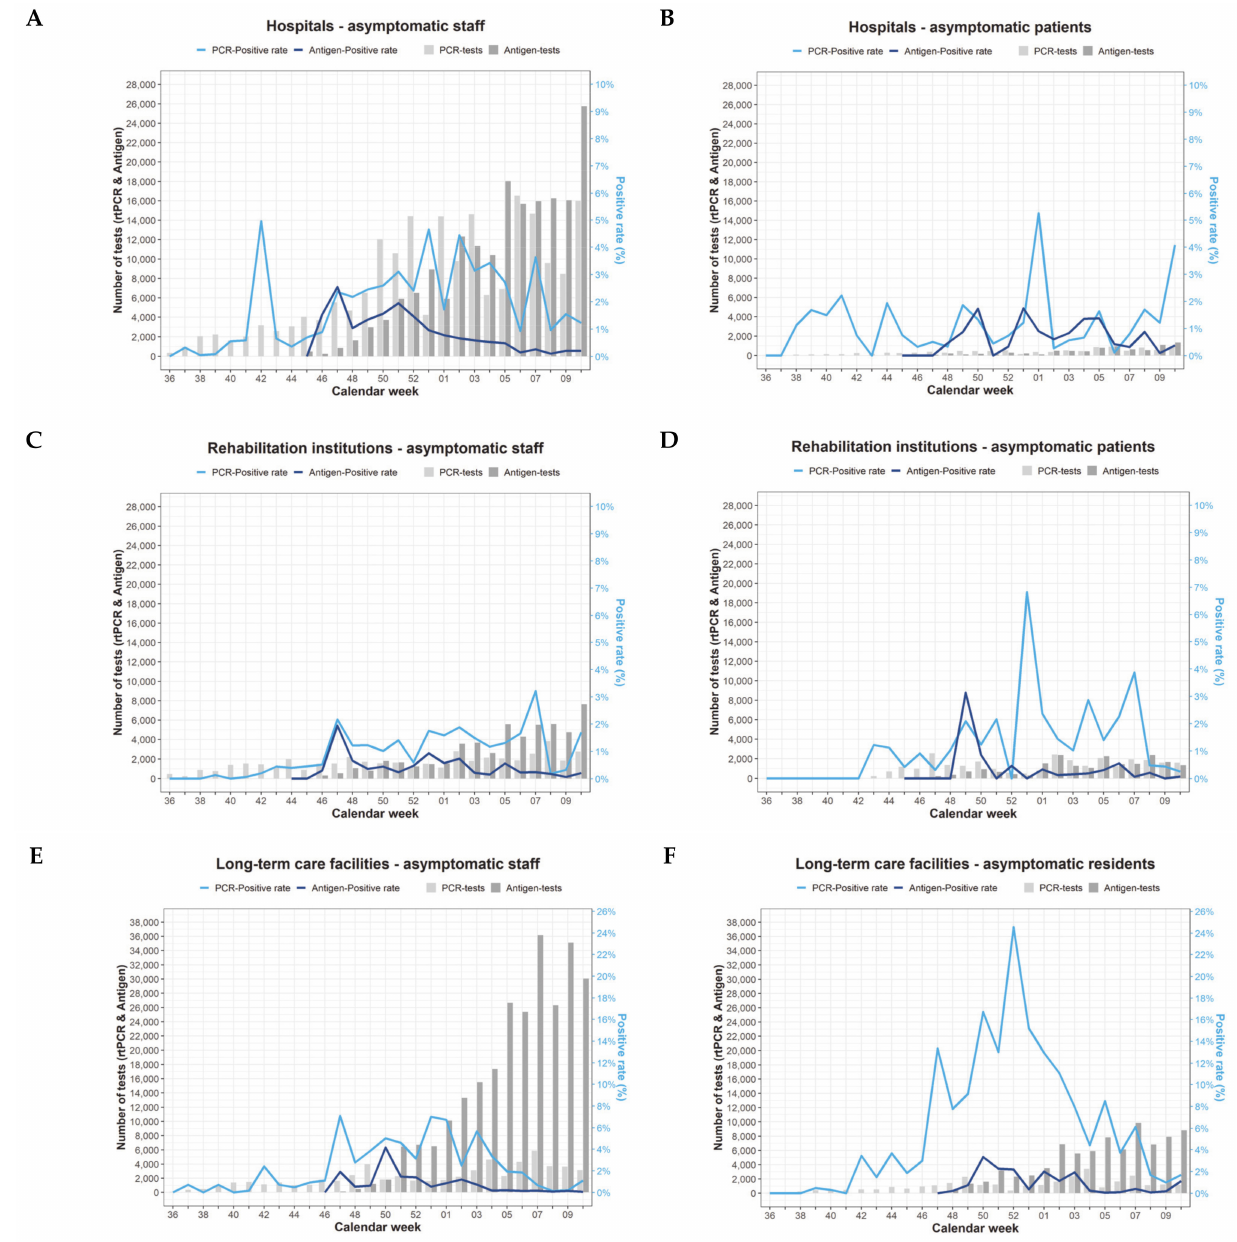
Figure 3. ( A – F ) Temporal patterns of the weekly number of real-time polymerase chain reaction (RT-PCR; light grey bars) and antigen tests (dark grey bars) and the proportion of positive RT-PCR (dark blue line) and antigen tests (light blue line) among asymptomatic staff (left diagrams) and patients/residents (right diagrams) in hospitals ( A , B ), rehabilitation institutions ( C , D) and long-term care facilities ( E , F